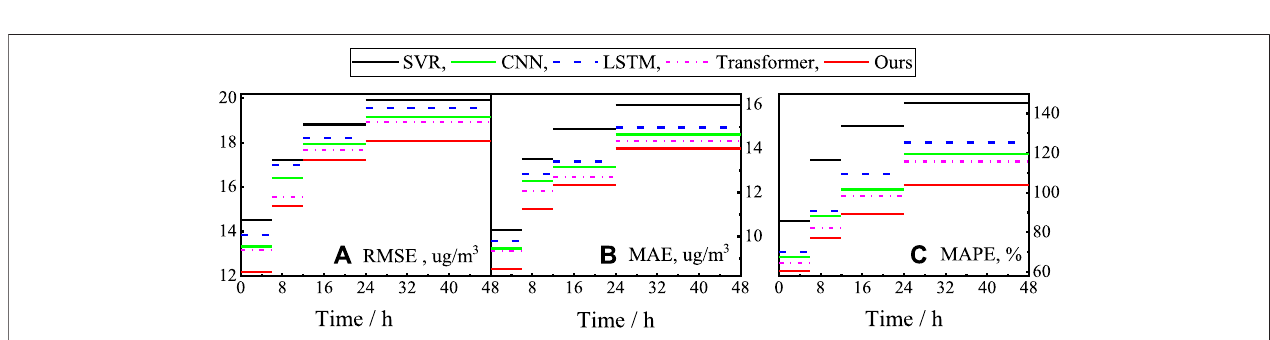
FIGURE 13 | Comparisons of different methods for multi-step prediction results for the next 48 h on Taizhou dataset.